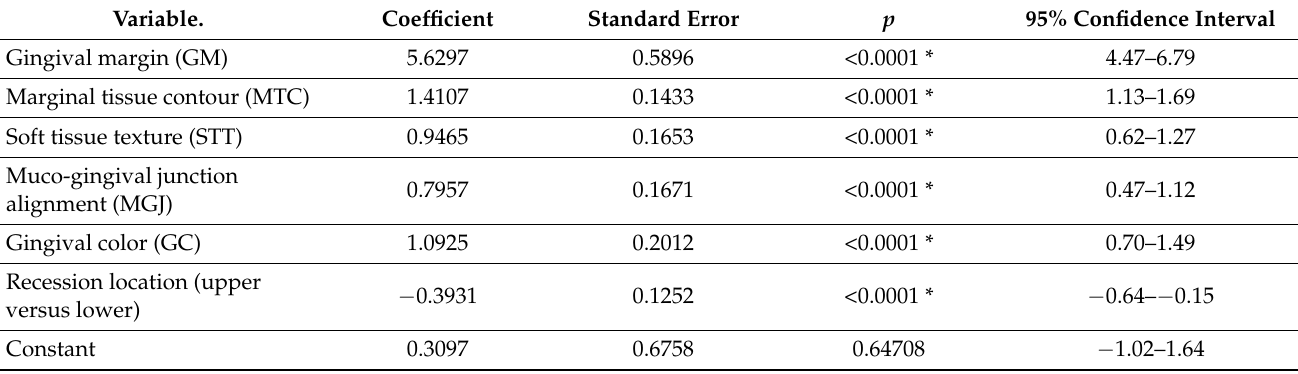
Table 4. Multiple linear regression model identifing variables that determine R 2 the final RES. The model was statistically significant with a R 2 adjusted to 0.4701 and p <